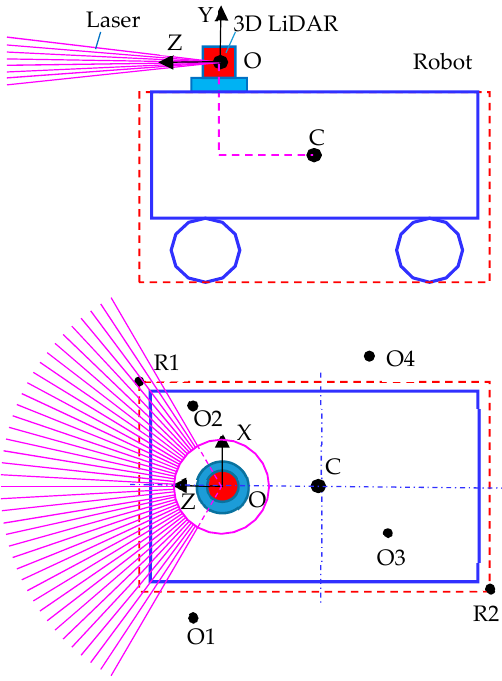
Figure 19. Schematic diagram of LiDAR position correction and detection results filtration.